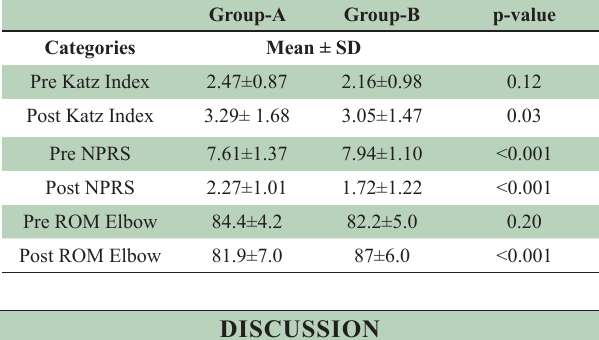
Table-II: Pre and Post Katz Index, NPRS, and Elbow